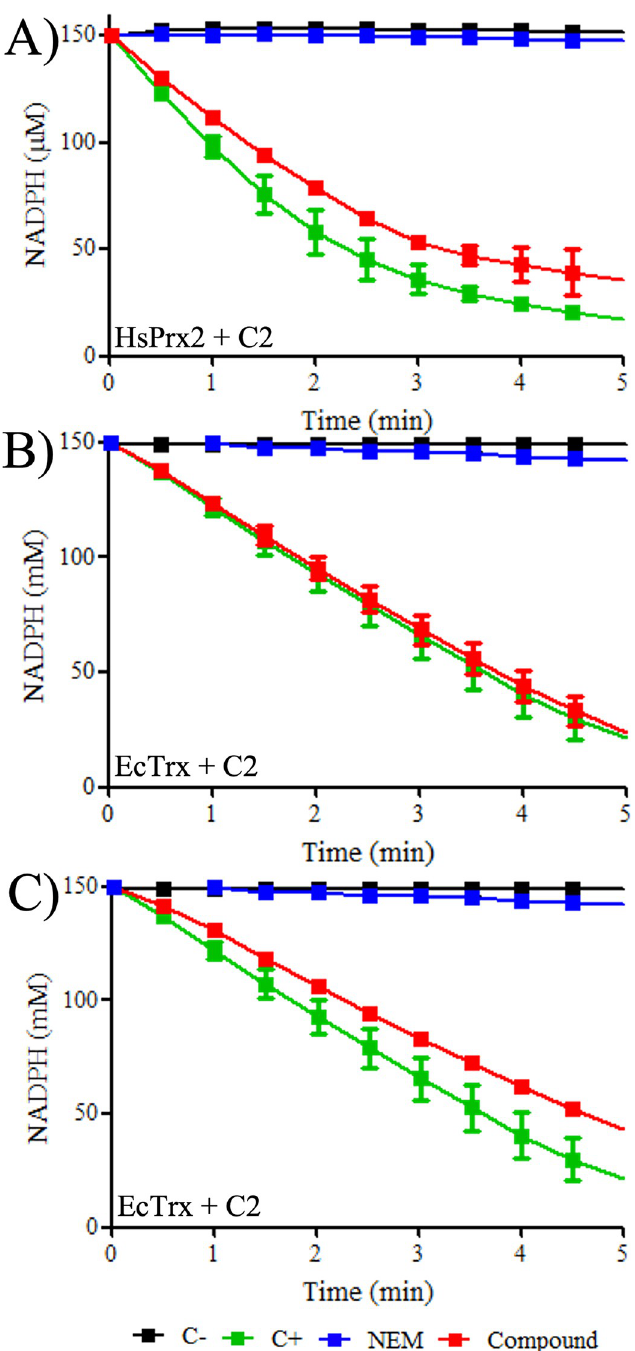
Fig 5. Evaluation of inhibition properties of compound C2 over HsPrx2 and the bacterial thiol proteins EcTrx and EcTrxR. The enzymes HsPrx2, EcTrx and EcTrxR were reduced with DTT and desalted, then treated with 50 molar equivalents of compound C2 for one hour at RT (red square). The proteins were desalted again to remove excess compound and their peroxidase activity was analyzed by NADPH oxidation assay. ( A ) For Prx2, reactions were performed containing 5 μ M of Prx2, 10 μ M of ScTrx1, 0.3 μ M of ScTrxR1, 150 μ M of NADPH, 50 mM of HEPES (pH = 7.0), 100 μ M of DTPA and 1 mM of sodium were used. For EcTrx ( B ) and EcTrxR ( C ) reactions consisted of 3 μ M of PaAhpC, 6 μ M of EcTrx, 0.9 μ M of EcTrxR, 150 μ M of NADPH, 50 mM of HEPES (pH = 7.4), 100 μ M of DTPA and 1 mM sodium azide were used. Prior to experiments the reactions were incubated at 37˚C/5 min and reactions were started by the addition of H 2 O 2 (500 μ M) and monitored spectrophotometrically at 340 nm, 37˚C, for 5